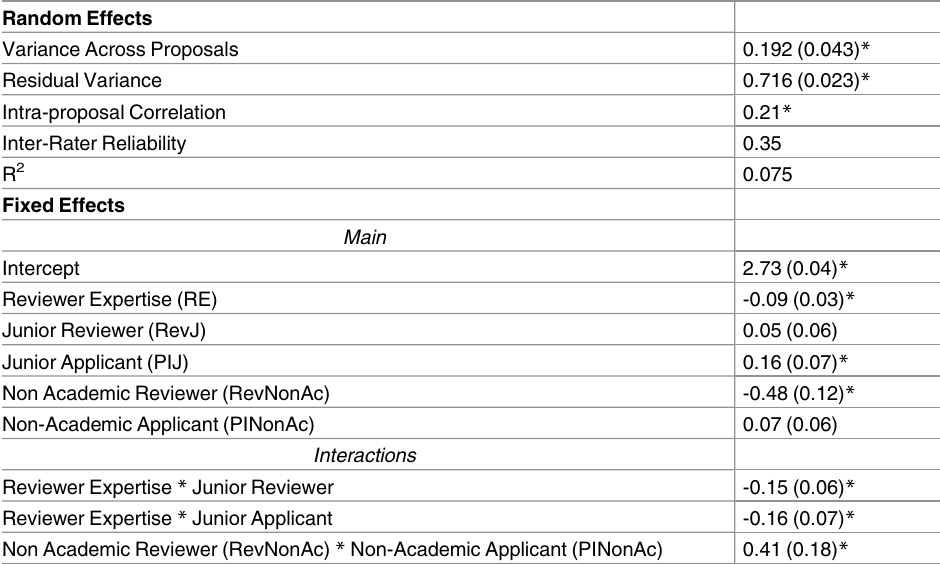
Table 4. Summary of Model 5 (RE + Seniority + Research Sector).